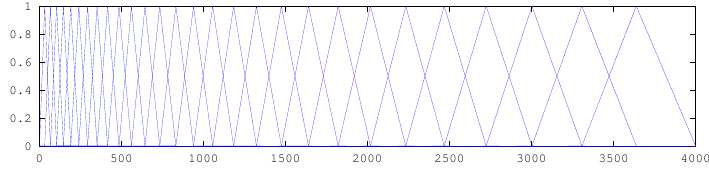
Figure B1. Mel-spaced